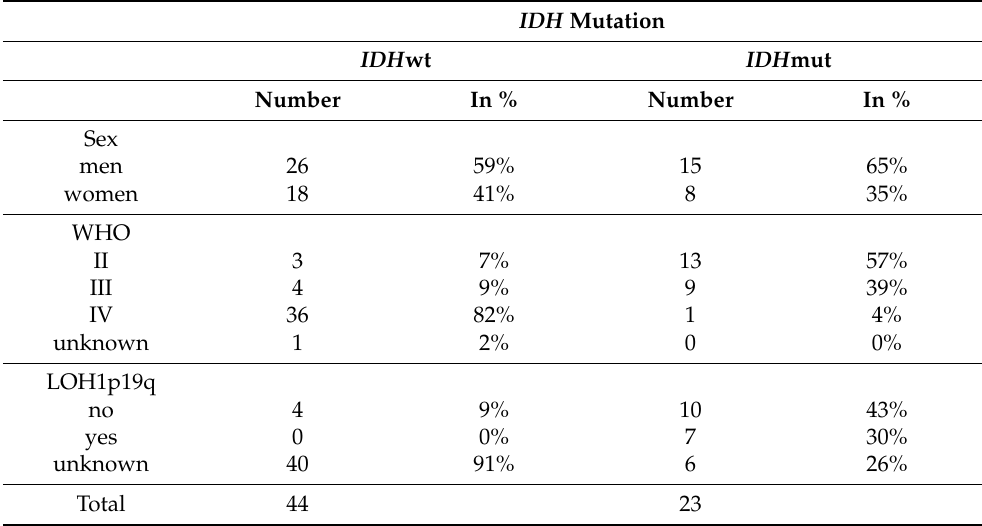
Table 1. Characteristics of the validation cohort. WHO grade according to initial histology (WHO classification of brain tumors from 2000). IDH : isocitrate dehydrogenase ; mut: mutated; wt: wildtype; LOH: loss of heterozygosity. IDH